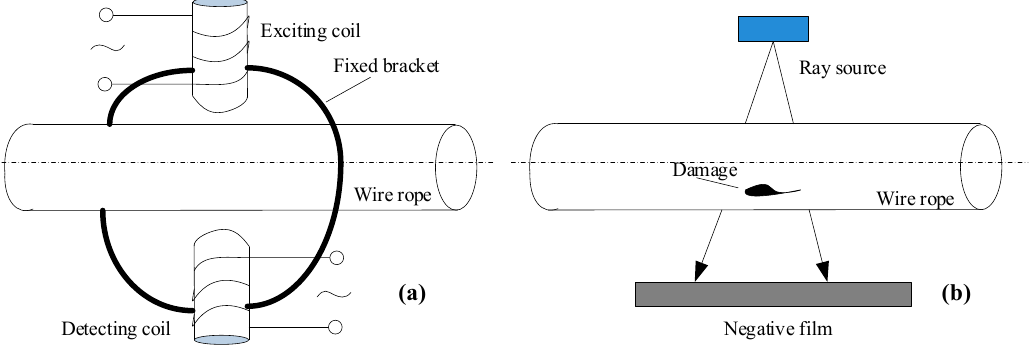
Figure 6. The other detection method principles. ( a ) Eddy current method [74]; ( b ) ray method